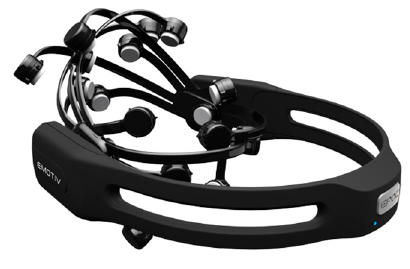
Figure 1. The Emotiv Epoc Headset [13].